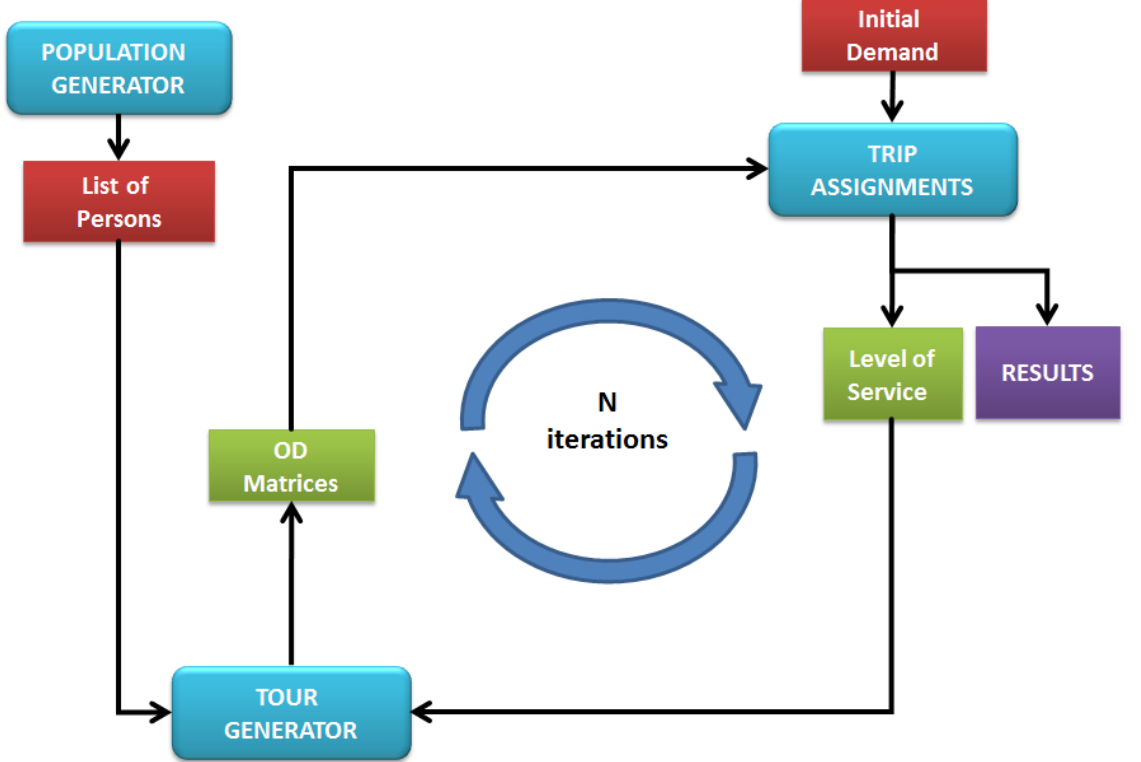
Figure 3. Tel Aviv Model Application